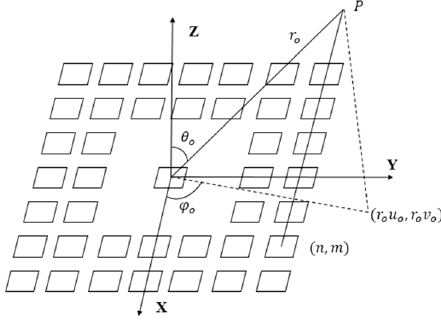
Figure 4. The coordinate system for the N × N array.